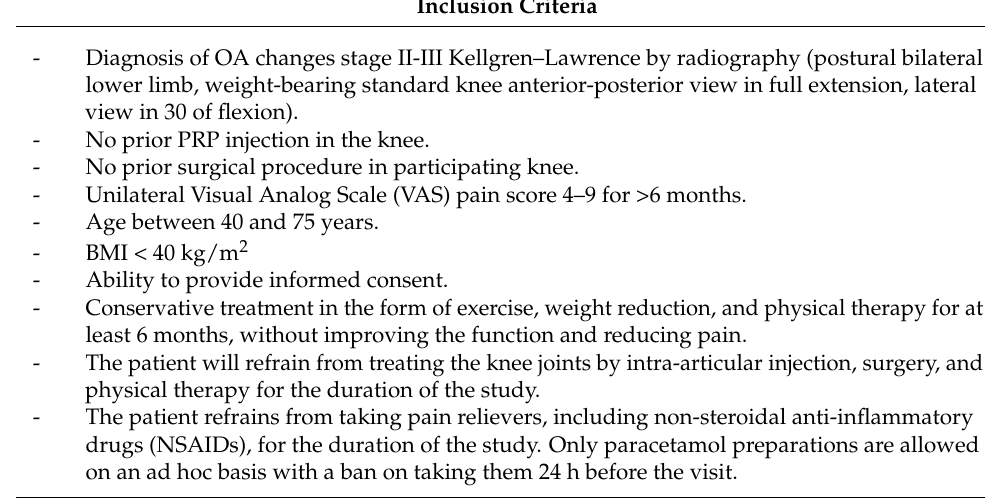
Table 1. Inclusion and exclusion